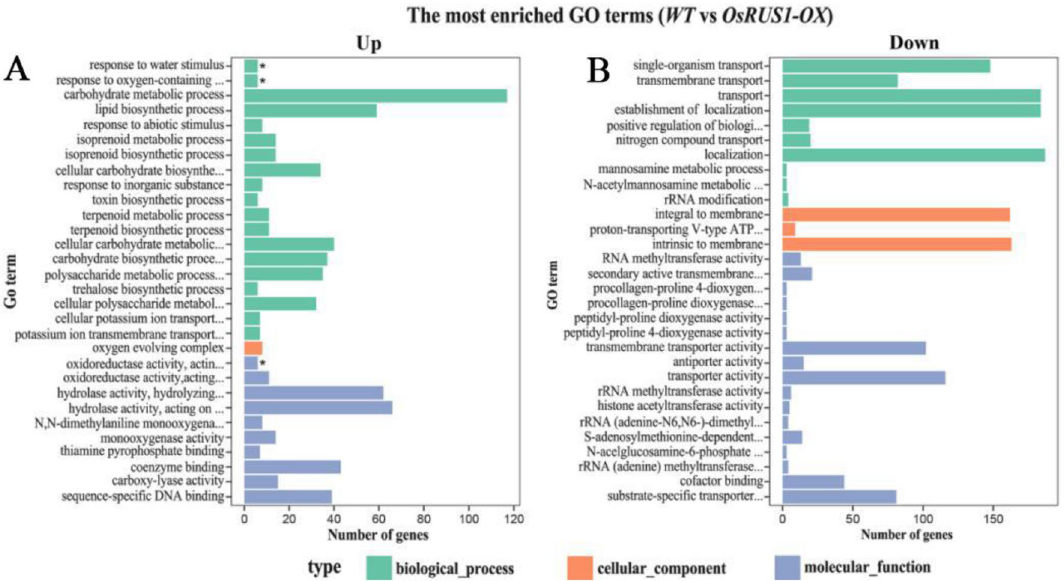
Figure 5. Histogram of Gene Ontology (GO) classification of differential expressed genes between WT and OsRUS1-OX . The results are summarized in three main categories: biological process (BP), cellular component (CC), and molecular function (MF), shown in green, red, and blue, respectively. The Y-axis indicates enriched Gene Ontology (GO) terms; the X-axis indicates the number of differential genes in a category; *, significantly enriched GO term. A. significantly enriched Gene Ontology (GO) terms in the upregulated genes in the leaves of OsRUS1-OX as compared to WT; B. significantly enriched Gene Ontology (GO) terms in the downregulated genes in the leaves of OsRUS1-OX as compared to WT OsRUS1-OX . WT, the wildtype of ZhongHua11; OsRUS1-OX , the OsRUS1-GFP Overexpression transgenic